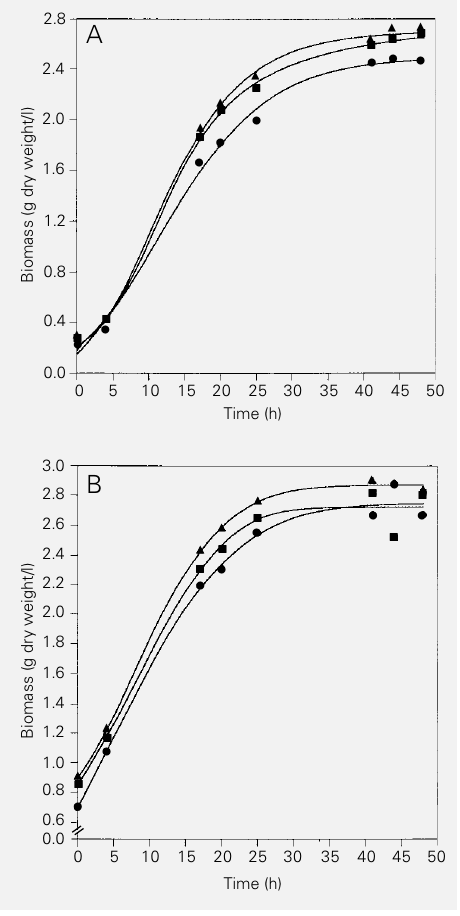
Figure 1 - Biomass accumulation during culture of Saccharomy- ces cerevisiae in molasses me- dium using dehydrated yeast (A) and native yeast (B) as inocu- lum. ` , Medium with water; (cid:224) , medium with liquid obtained by rehydration of viable dry yeast; £ , medium with liquid obtained by rehydration of dead dry